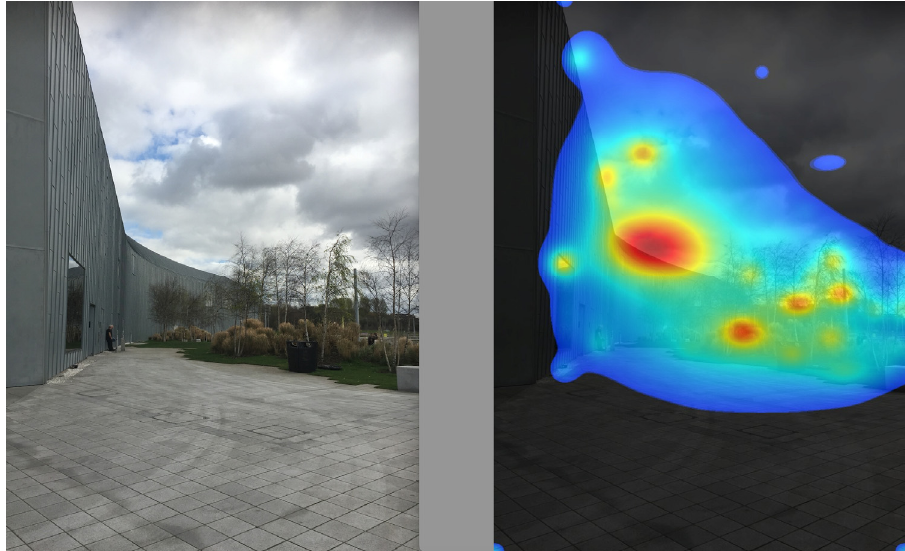
Figure 15. RSM wall and nearby vegetation. (Photo by A. Salama; VAS heatmap scan by N.A. Salingaros)